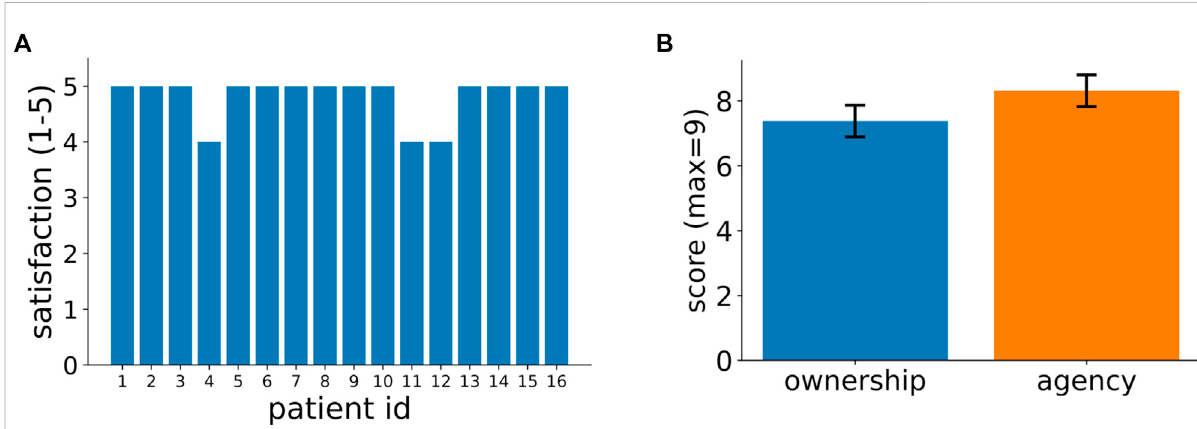
FIGURE 2 Patients ’ feedbackontheirexperienceinourVR-basedrehabilitationsystem. (A) Patients ’ ratings,inascalefrom1to5,tothequestion: “ Didyou enjoy this type of training? ” (In Italian: “ Ha gradito la tipologia di allenamento? ” ). Supplementary Figure S3 in the supplementary information shows the responses for all other questions in the satisfaction questionnaire. (B) Patients ’ scores for ownership and agency as assessed by a standardized questionnaire (see Methods for further details). The 2 bars represent average across patients and the vertical lines signify variance (mean ownership = 7.4 ± 2.0; mean agency = 8.3 ±